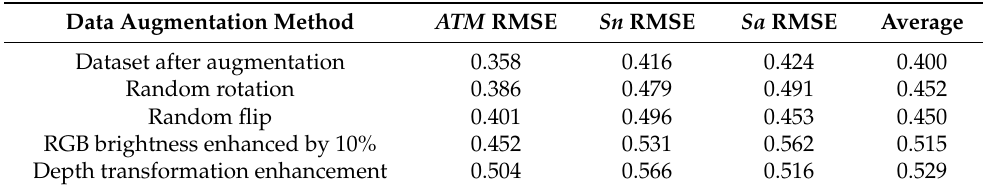
Table 5. Data enhancement control variable